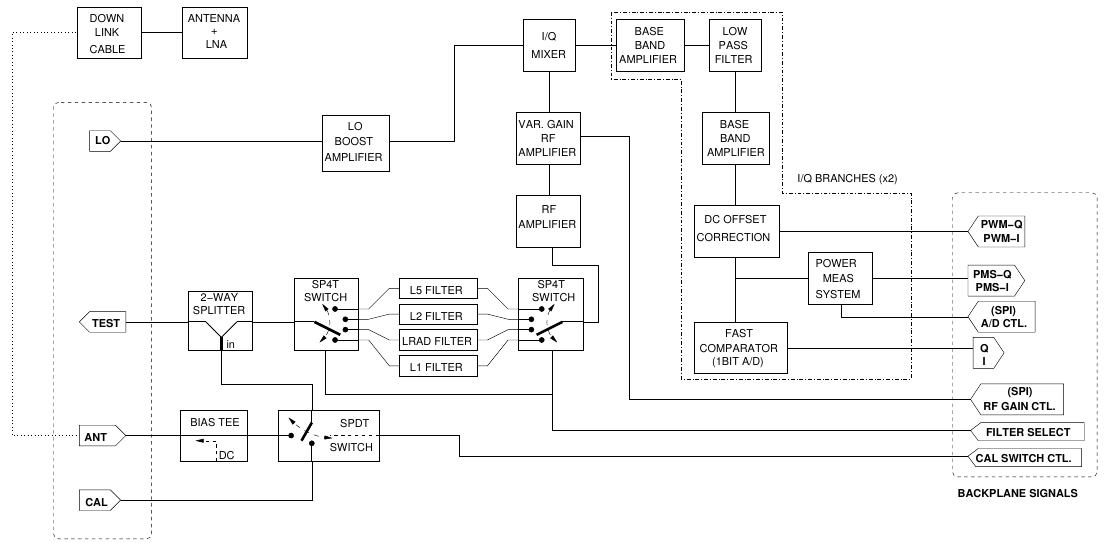
Figure 2. Block diagram of the RF receivers of